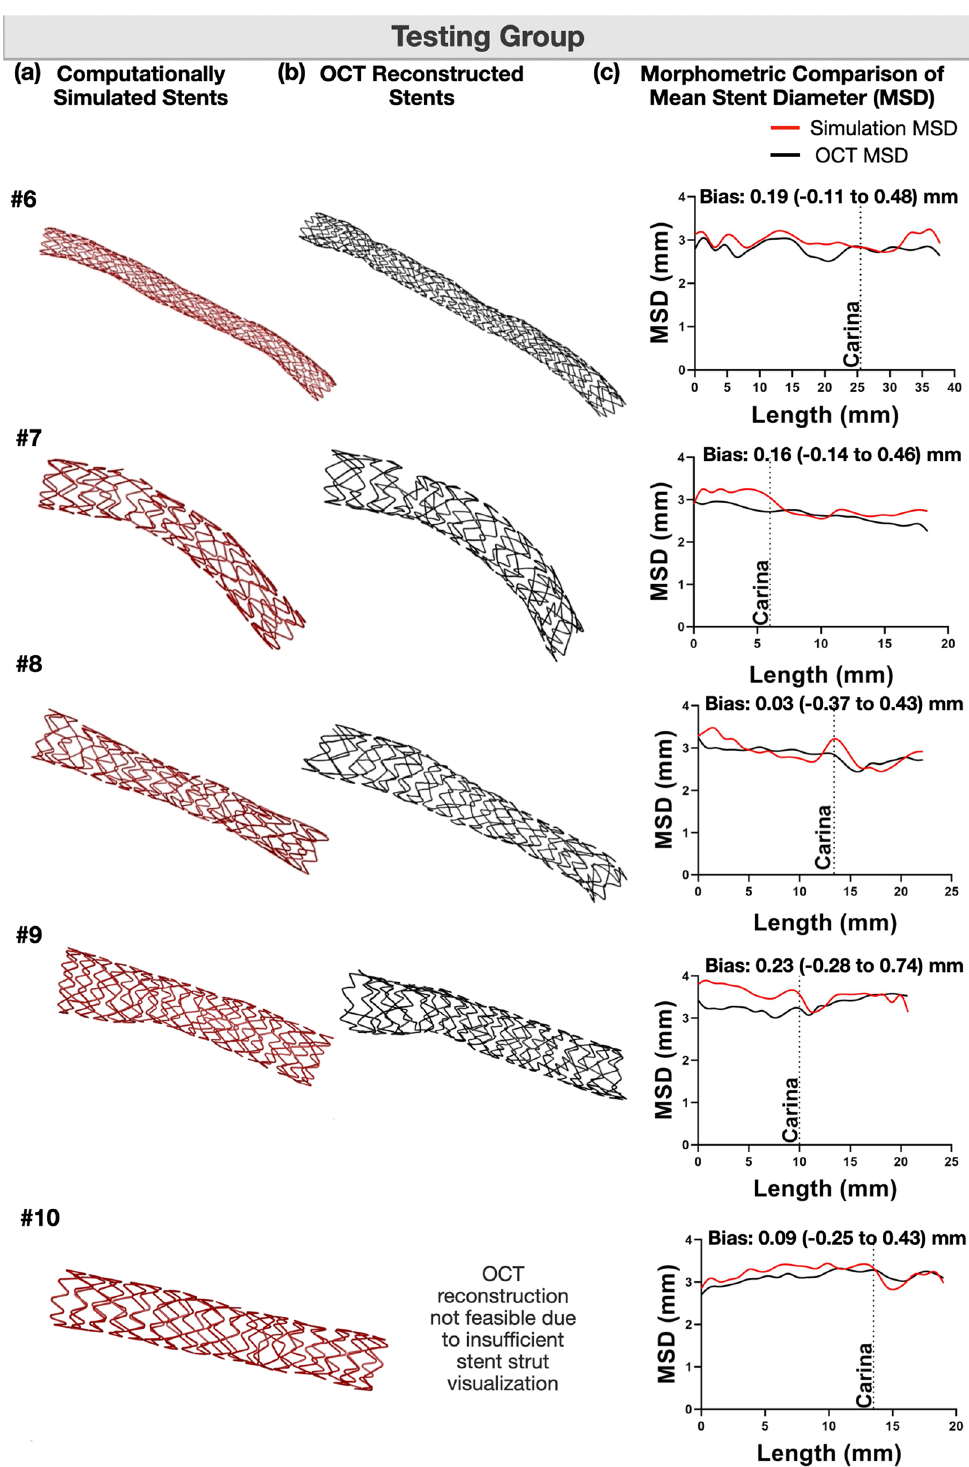
Figure 7. Blind computational stenting simulation versus OCT (Testing group). Qualitative ( a , b ), and quantitative ( c ) comparison of mean stent diameter (MSD) after computational stenting against OCT. The stents in ( b ) were 3D reconstructed from OCT 21 . Note that the computational stent simulation was blind to the final OCT results